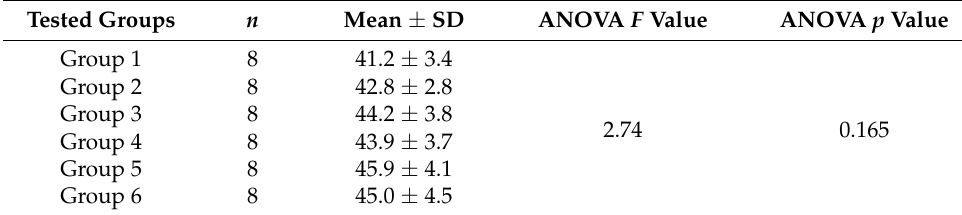
Table 2. Tested GIC samples’ compressive strength